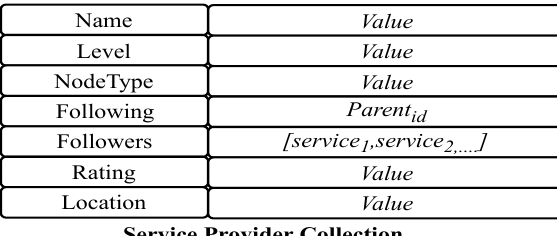
Figure 6. Service Provider